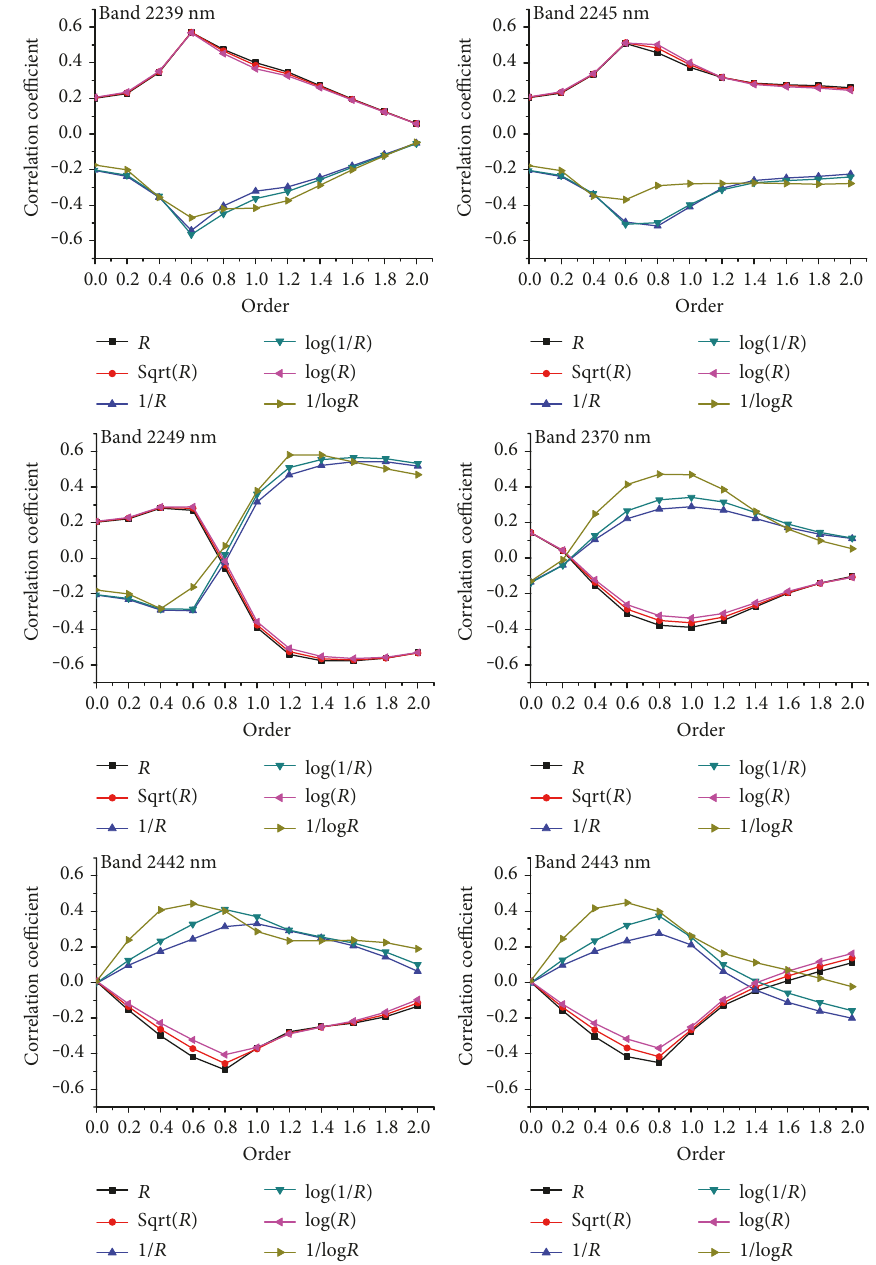
Figure 4: The correlation coe ffi cient between EC